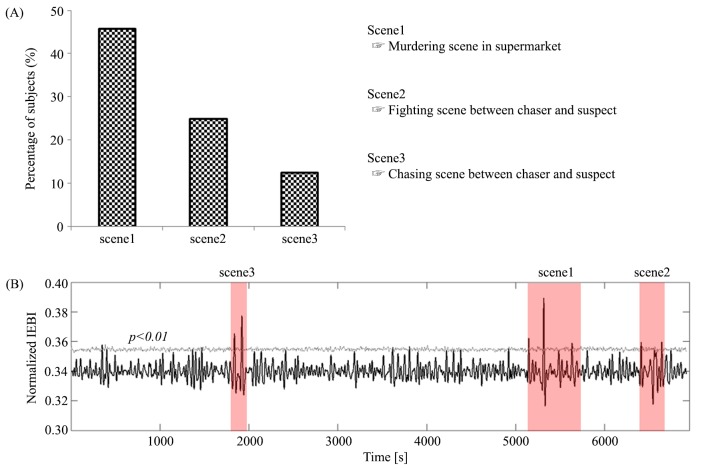
Temporal matching between normalized IEBIs and scenes reported as memorable by subjects.(A) Most memorable scenes: the murder scene was reported as most memorable by 46% of subjects (Fig 3A and S2 Dataset). (B) Changes in the temporal characteristics of normalized IEBIs in all subjects in the MOVIE condition. Red bars indicate the most memorable parts of the movies (Fig 3B and S3 Dataset). The gray line depicts statistical significance (p < 0.01), as determined using a random permutation test.